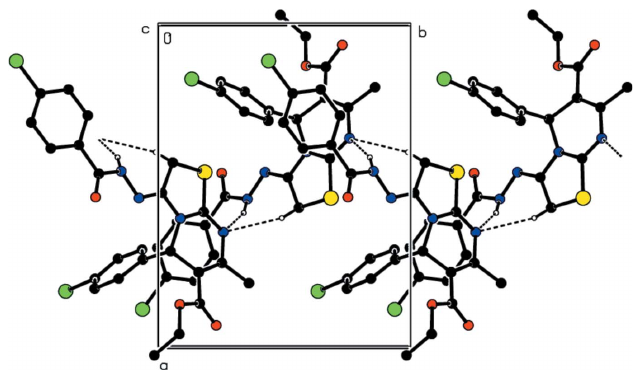
Figure 2 A portion of the hydrogen-bonded chain viewed along the c -axis direction. N—H (cid:2)(cid:2)(cid:2) N and C—H (cid:2)(cid:2)(cid:2) N hydrogen bonds are shown. H atoms not involved in these interactions have been omitted for clarity.